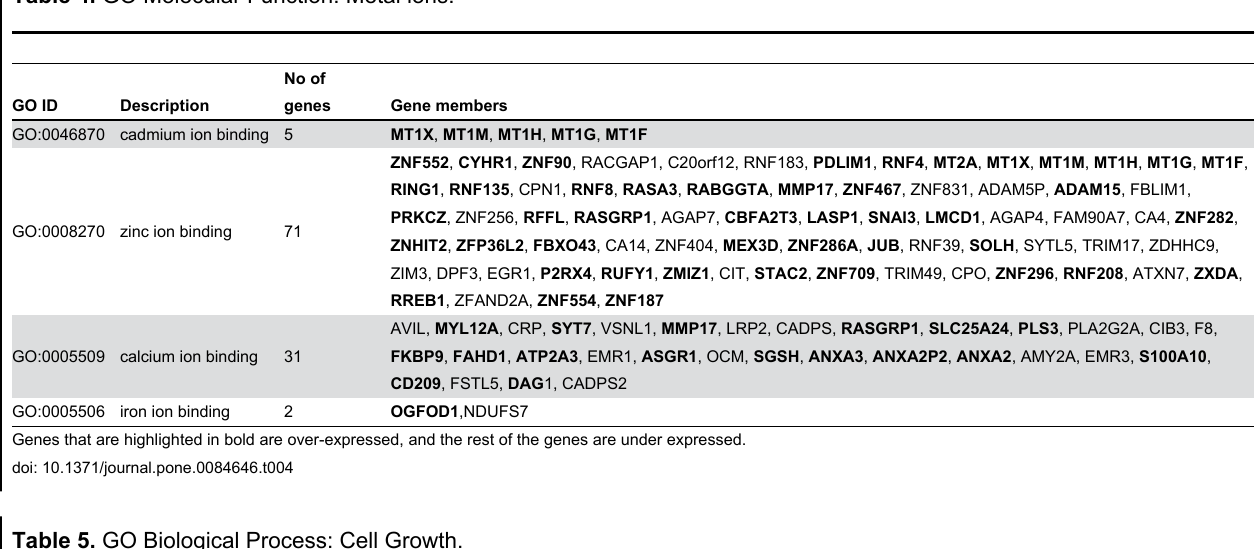
Table 5. GO Biological Process: Cell